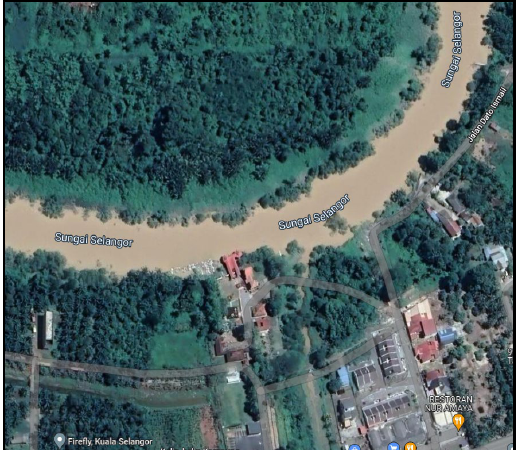
Figure 1. Map of the tide gauge installed at the Selangor River, Kuala